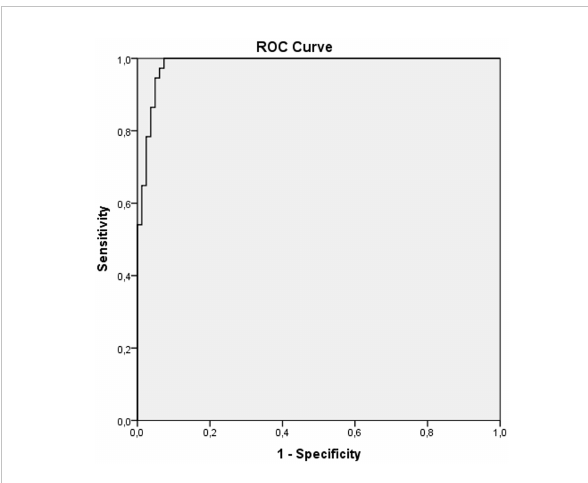
FIGURE 6 Comparison of the ROC curves of ADC values (blue curve) and endometrial thickness measured by TVUS (green curve) in differentiation between malignant and benign endometrial lesions.